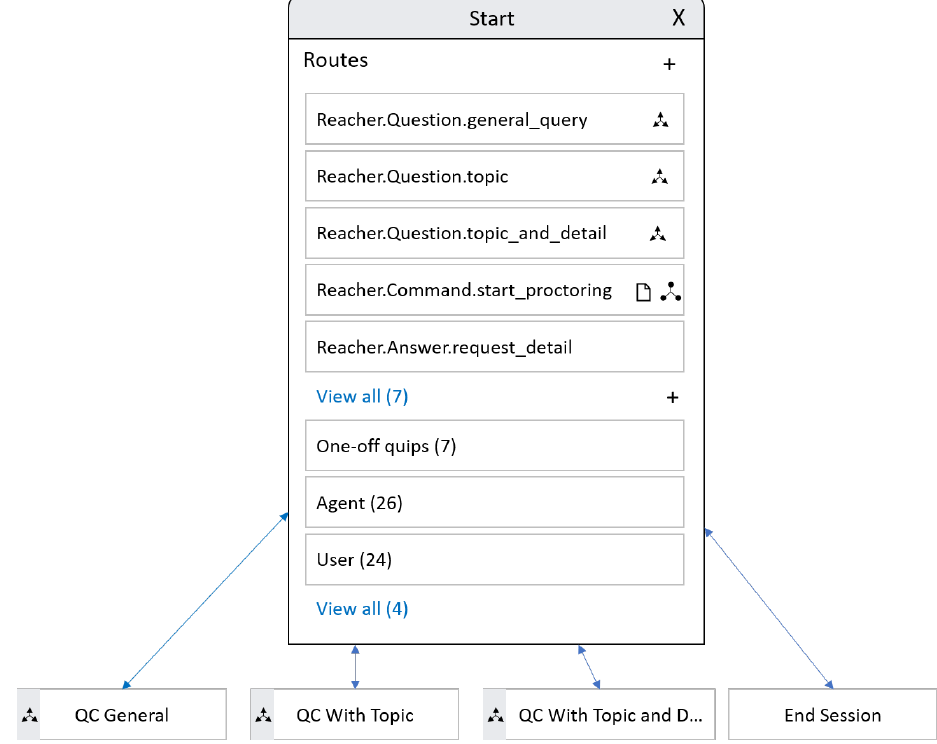
Figure 4. Start page which contains the possible routes to other pages.